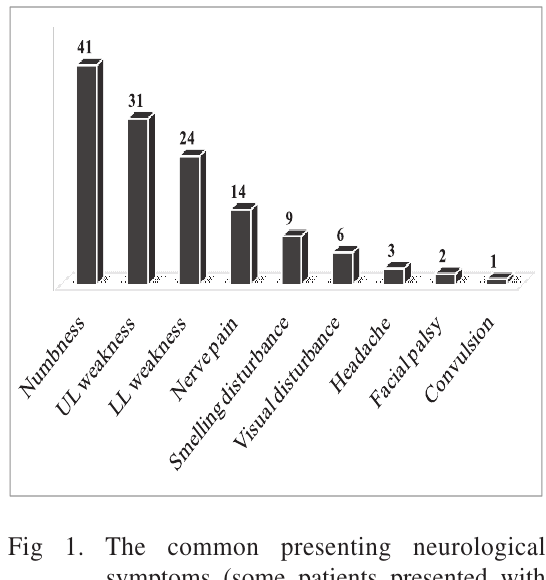
Table III: Neurological findings of leprosy in lower limbs (n=55)! ! Clinical findings